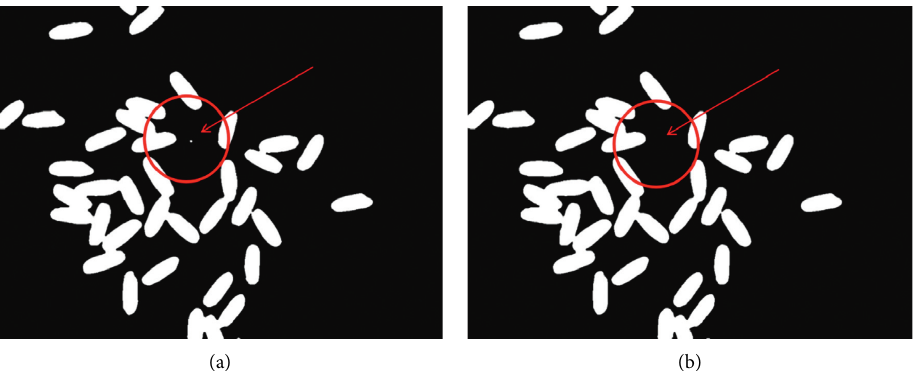
Figure 1: Comparison of images before and after morphological filtering. (a) The original image. (b) The image processed by morphological filter.